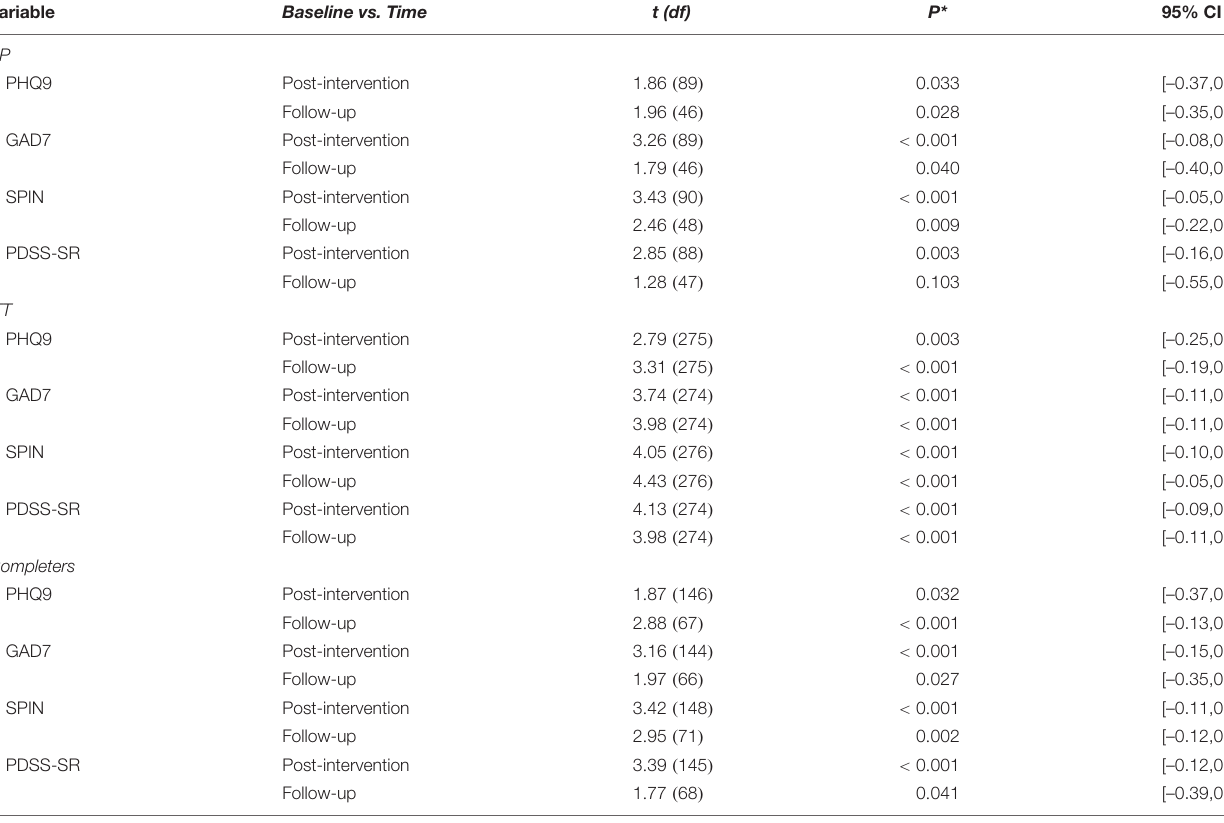
TABLE 5 | Between-groups t -test comparisons for non-inferiority on all primary outcomes against the non-inferiority margin of d = –0.35. Variable Baseline vs. Time t (df) P*